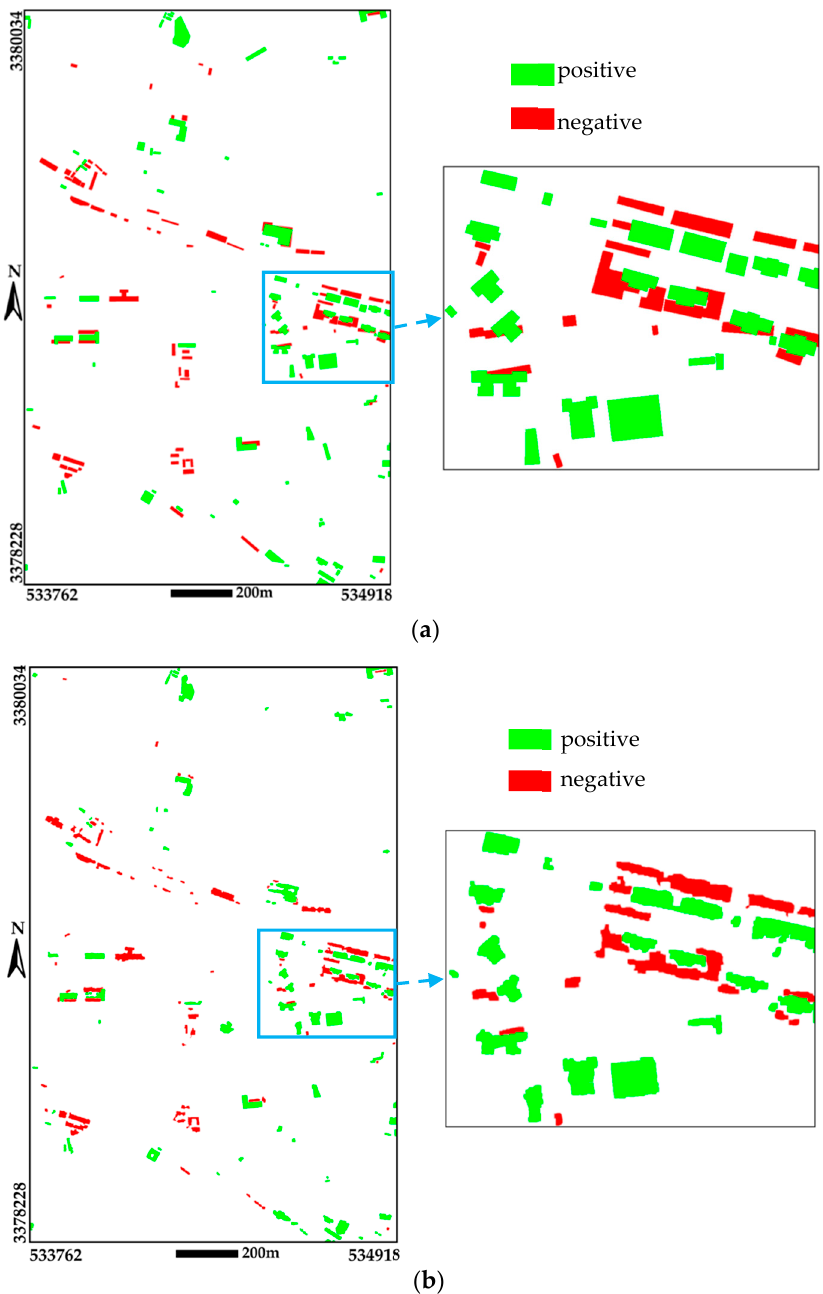
Figure 11. The reference data and the building change detection results: ( a ) reference data and one region detail; and ( b ) change detection results and the corresponding region detail.